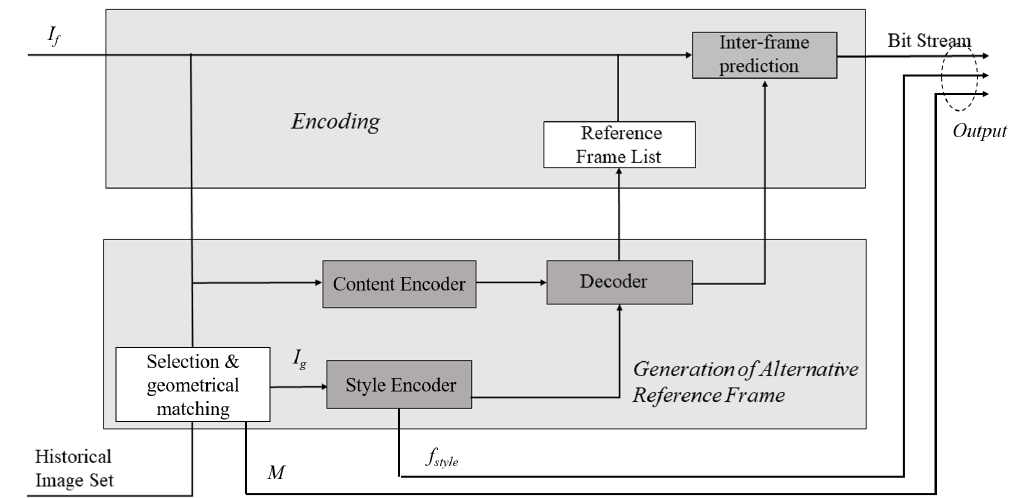
Figure 5. The framework of our proposed coding scheme. We use the learned representation model to generate reference frame. With the synthetic reference frame, we adopt inter-frame compression for both the intra-coded picture (I frame) and predicted picture (P